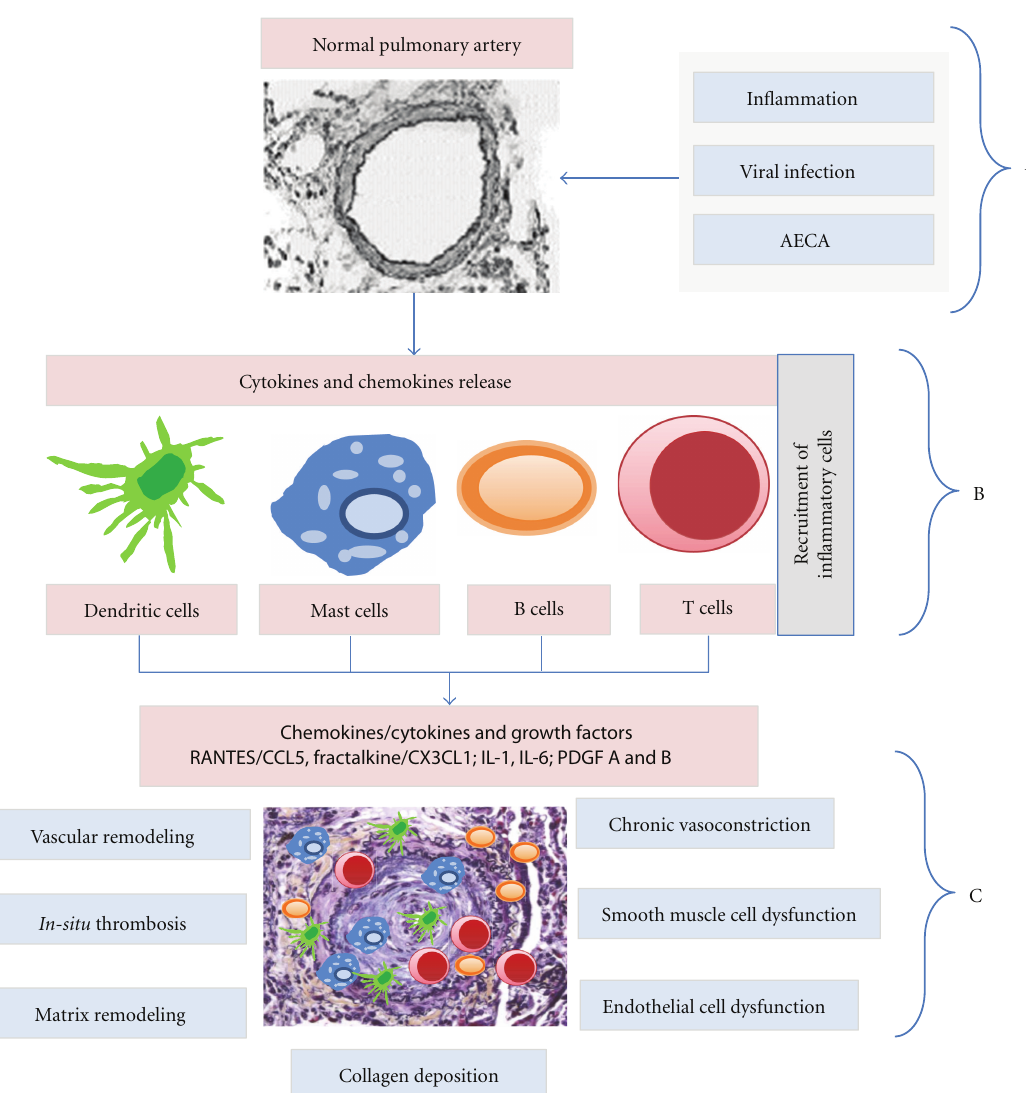
Figure 2: Role of inflammation and Dysregulated immune response in the development of PAH in SLE. (A) Viral infection, AECA, and other agents damage the normal pulmonary endothelium. (B) Increase in chemokine/cytokine concentrations as a result of endothelial injury, leading to recruitment of dendritic cells, mast cells, B cells, and T cells. (C) Infiltration of the small, and medium-sized pulmonary arteries by the dendritic cells, mast cells, B cells and T cells, resulting in dysregulated angiogenesis. AECA: antiendothelial cell antibodies; RANTES: regulated upon activation, normal T cell expressed and secreted; CCL5: chemokine Ligand 5; CX3CLI: chemokine Ligand 1 [Fractalkine]; IL-1: interleukin-1; IL-6: interleukin-6; PDGF: platelet derived growth